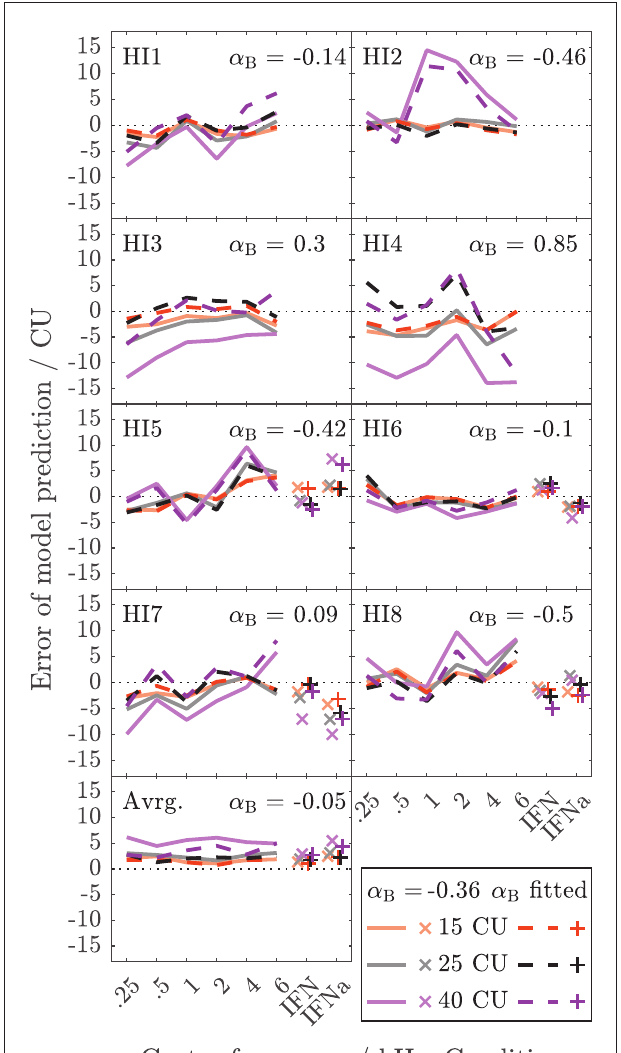
FIGURE 5 | Deviations between model calculations of binaural loudness in CUs and empirical binaural loudness data in CUs for the HI listeners of Dataset 1. As in Figure 4 , the color indicates the loudness of the diotic signal. Dashed lines and x symbols are for the individualized binaural model stage (see Figure 4 ). Solid lines and + symbols of lightened color are for the model using average NH binaural inhibition ( Figure 3 , mean of α B = − 0.36). The bottom panel shows the averaged absolute errors across